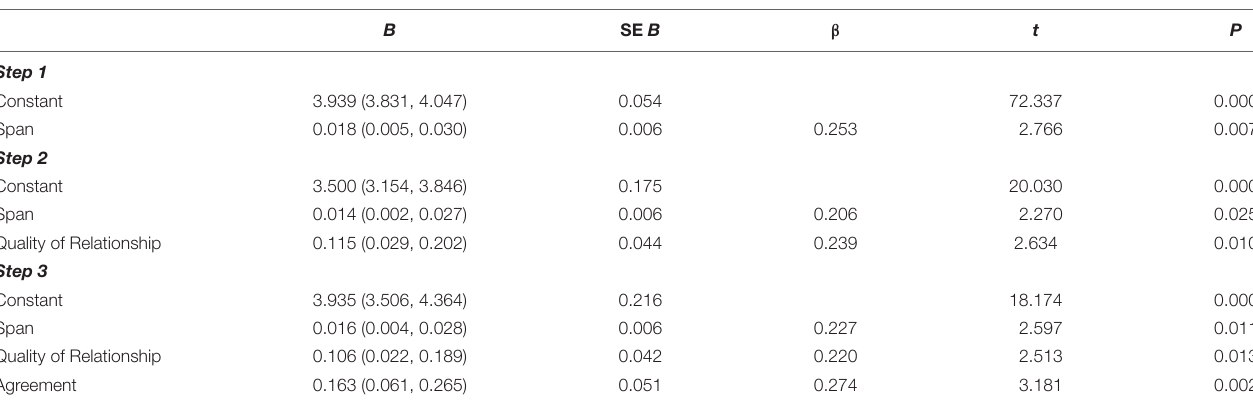
TABLE 3 | Hierarchical Regression Analysis considering Couple Efficacy as the variable criteria.